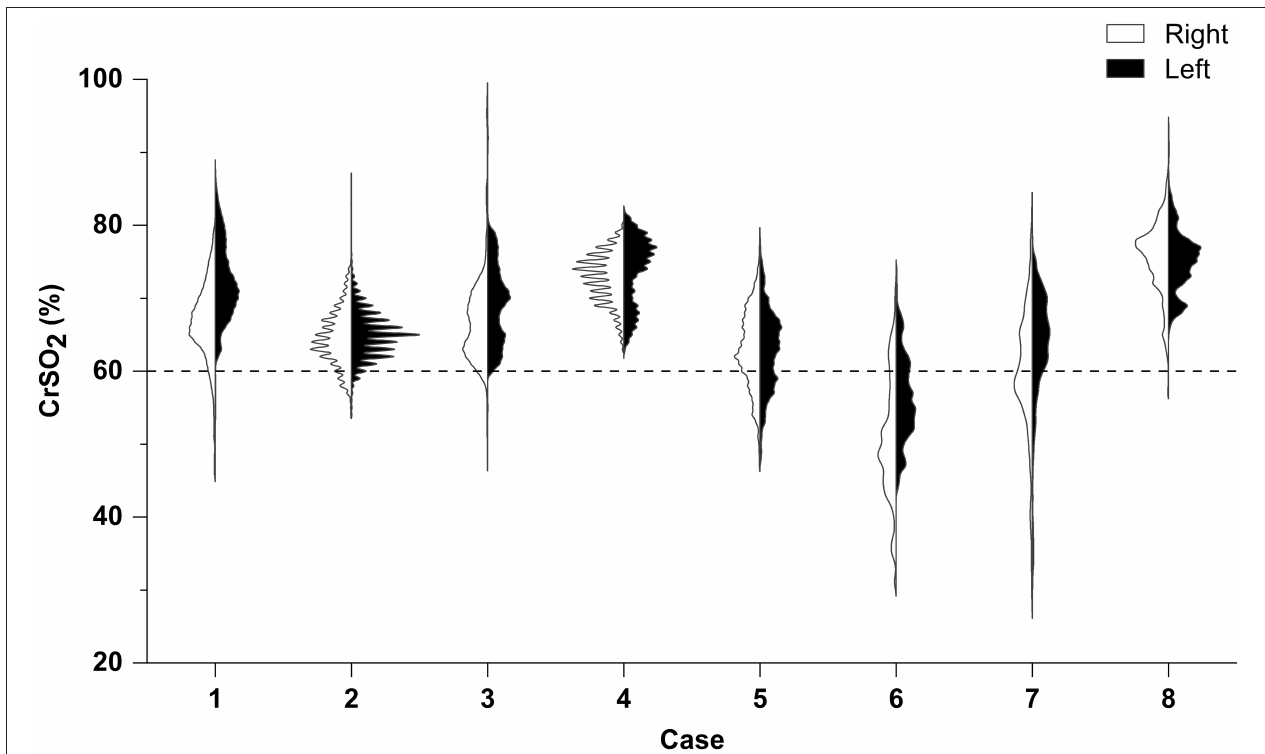
FIGURE 1 | Right–left split violin plot of CrSO 2 for the first 5 days following ECMO initiation. According to PICU mortality, patients 5, 6, and 7 suffered death; others survived. Results of the Mann–Whitney U -test indicate that the percentage of time of CrSO 2 < 60% against the whole monitoring time was significantly lower in survivors in both hemispheres (both p <